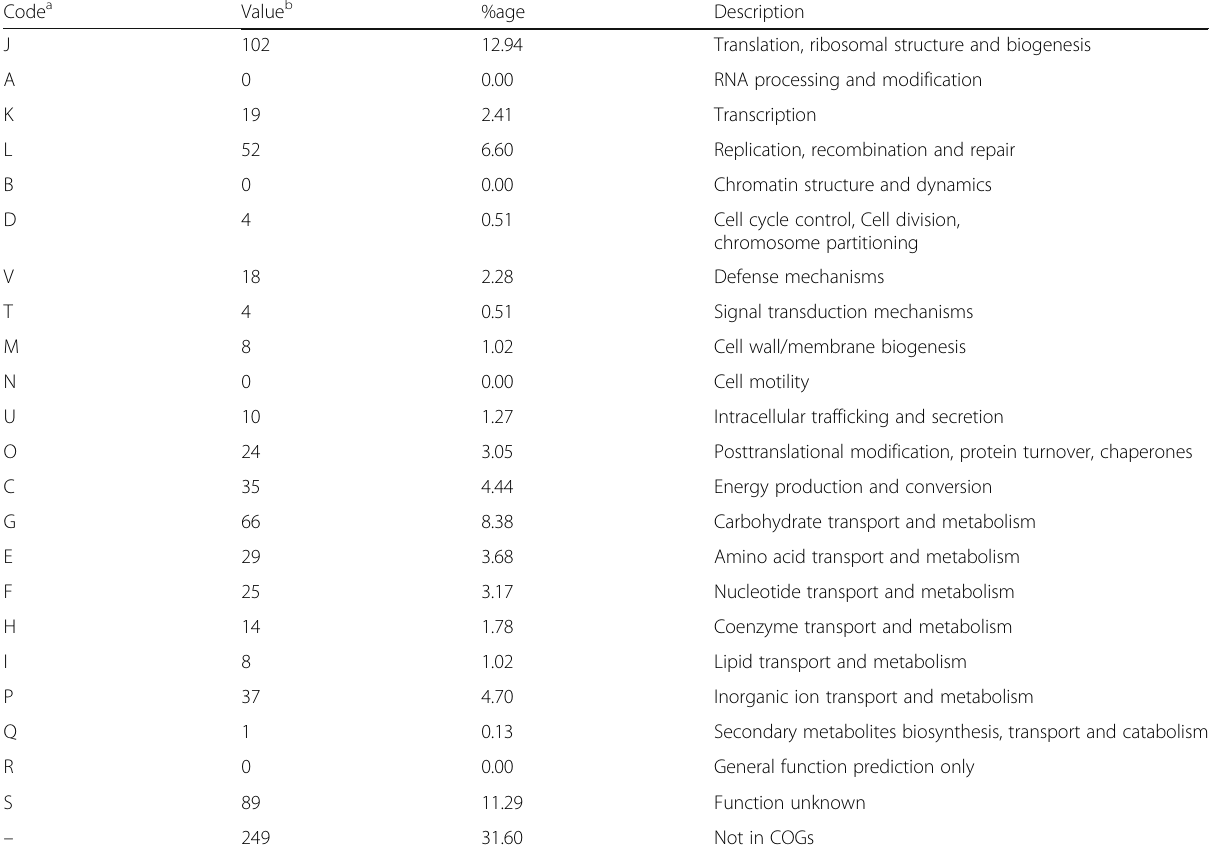
Table 4 Number of genes associated with general COG functional categories Code a Value